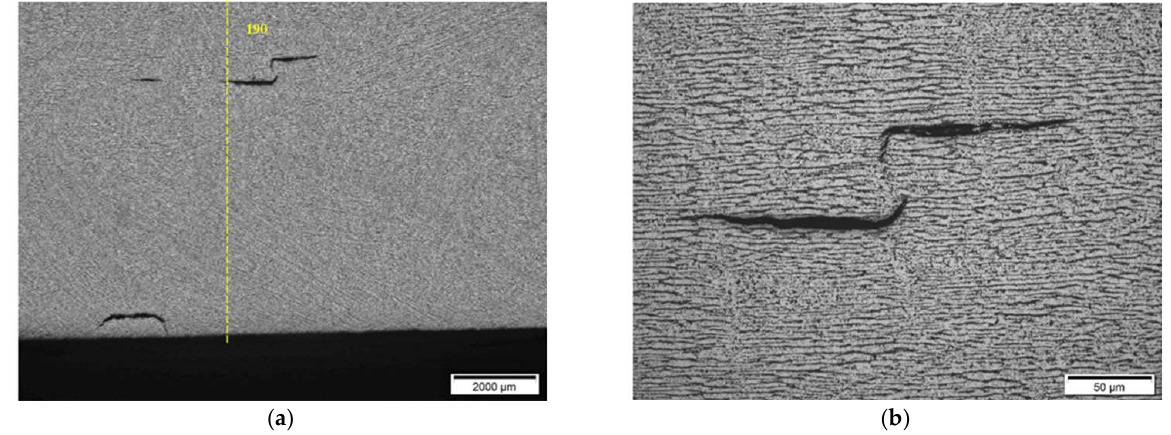
Figure 26. Section No3: 142–198. Coordinate 190 mm. Magnification 12.5× ( a ), 6.1–6.5 mm from ID, stepwise cracking magnification 50× ( b ).